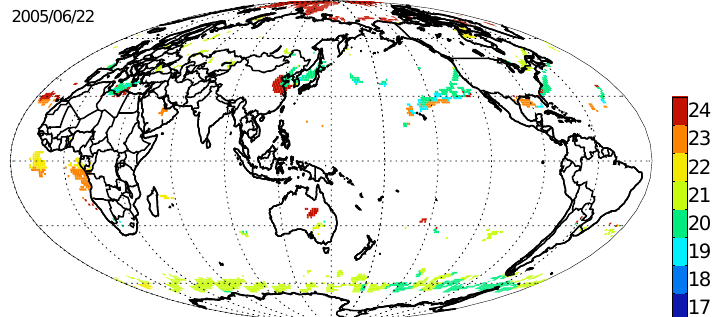
Figure 7. The layer peak for the ozone enhancement ( (cid:49) O 3 ) on 22 June 2005. Grids were selected where the TCO was larger than 0.8DUkm − 1 .